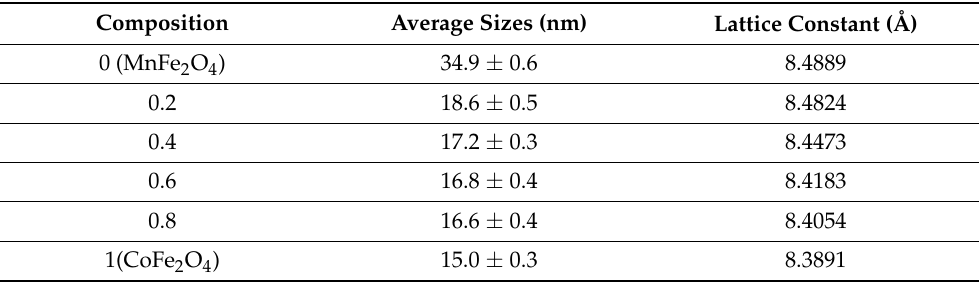
Table 1. The average crystallite sizes and lattice parameters of the Co x Mn 1-x Fe 2 O 4 ( x = 0, 0.2, 0.4, 0.6, 0.8, and 1.0)